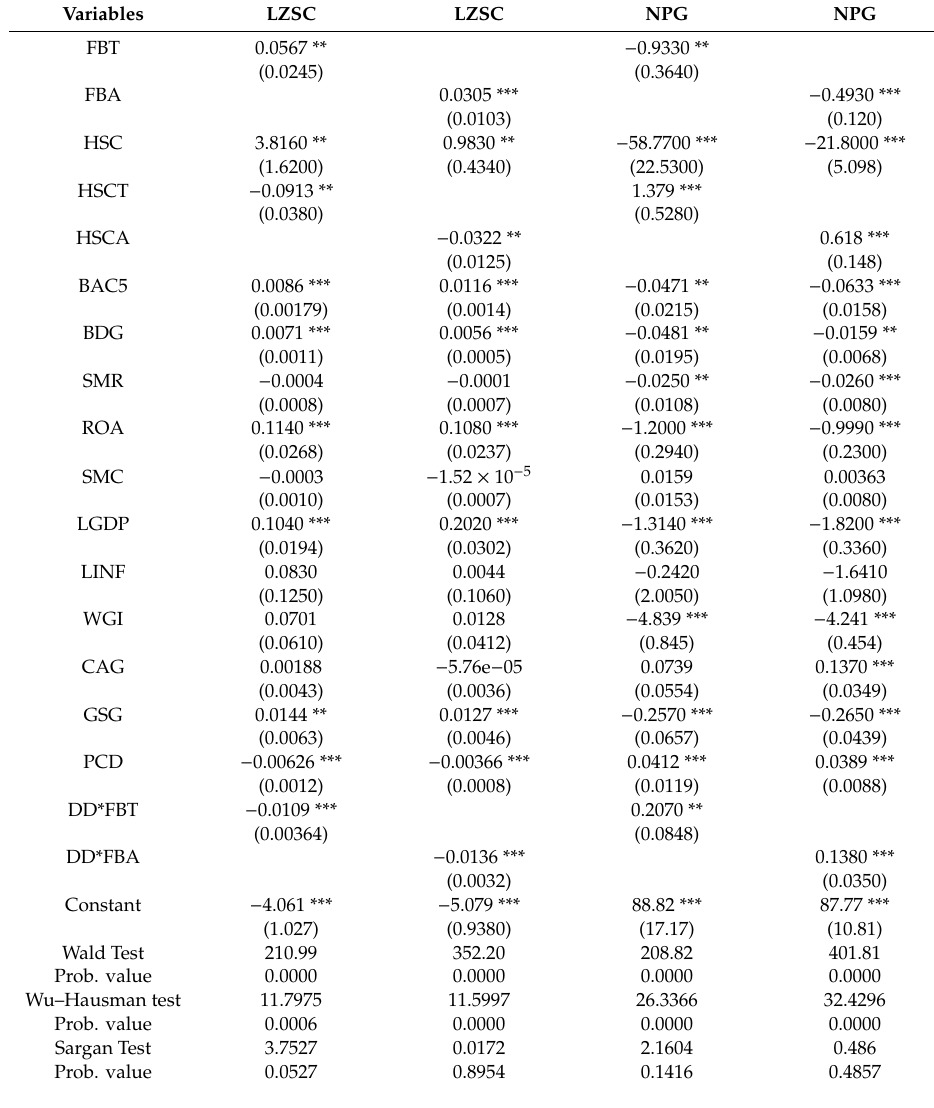
Table 7. Bank competition, foreign bank entry, and banking risk (2SLS